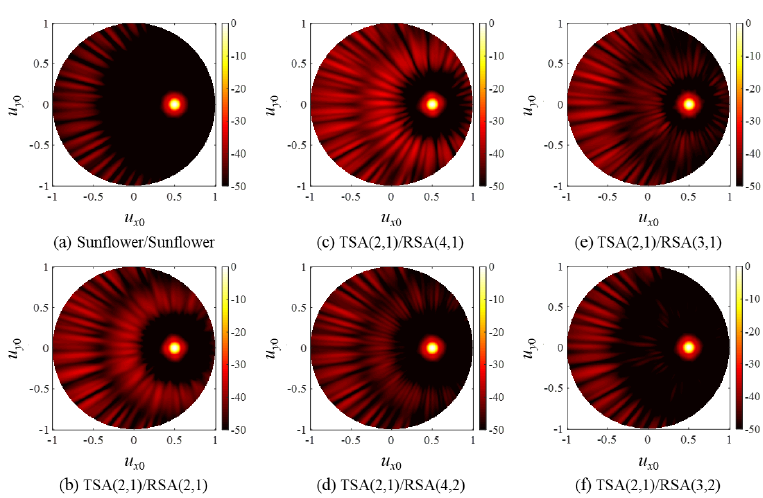
Figure 15. PW PSFs of ( a ) the sunflower array pair and ( b – f ) the SSA pairs for a steered focal point at ( u x f , u y f ) = (0.5,0) (i.e., θ f = π / 6, and ϕ f = 0).